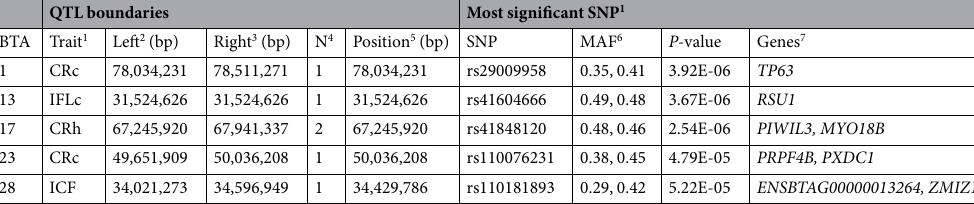
Table 4. The detected QTL and the most significant SNP for female fertility traits in the meta-analysis across populations. 1 CRh = conception rate at first insemination in heifers; ICF = interval from calving to first insemination; IFLc = interval from first to last insemination in cows; CRc = conception rate at first insemination in cows. 2 The left boundary of the QTL. 3 The right boundary of the QTL. 4 The number of significant SNPs within the QTL. 5 The base pair position in the BTA ( Bos taurus autosome). 6 Minor allele frequency of the most significant SNP in Chinese and Nordic Holsteins. 7 Genes harbor or closest to the most significant SNP.